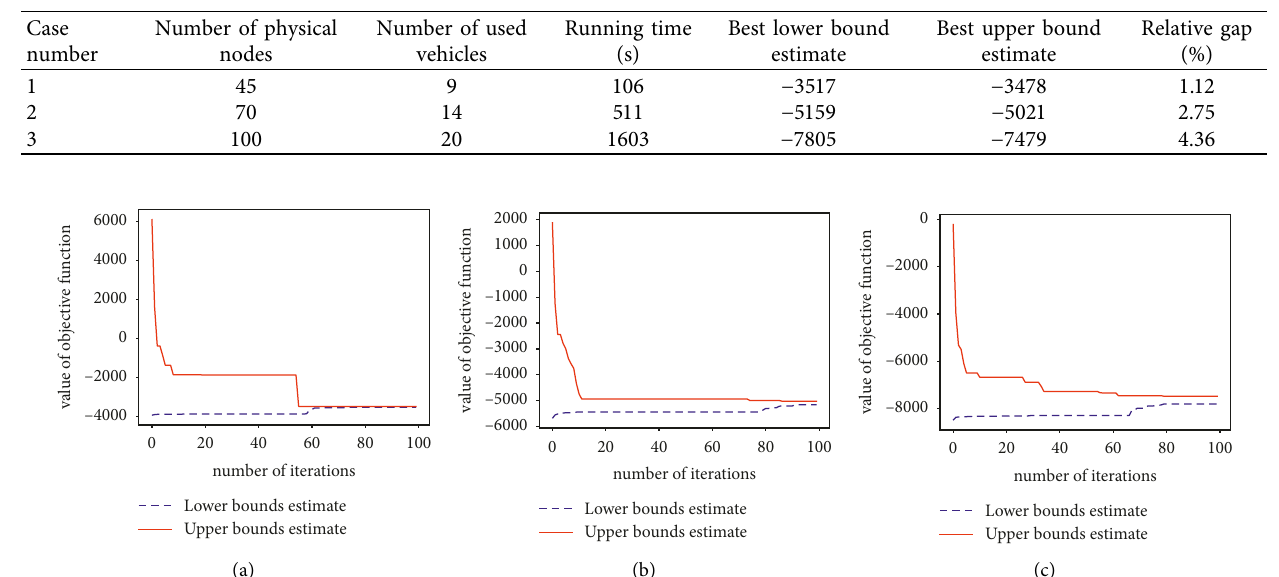
Table 11: Optimized results for generating initial routing plan in different case scales.